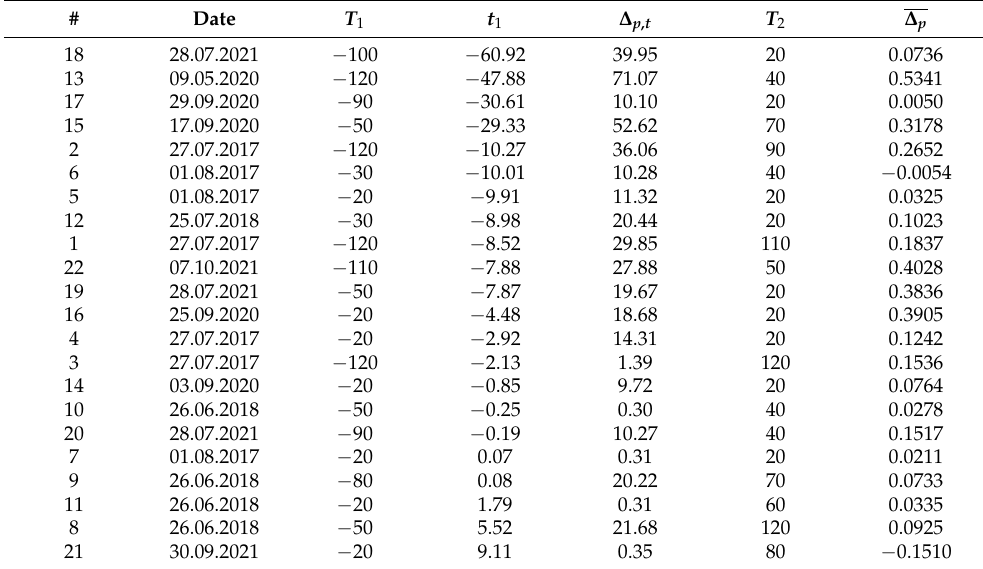
Table 2. Real events sorted by t 1